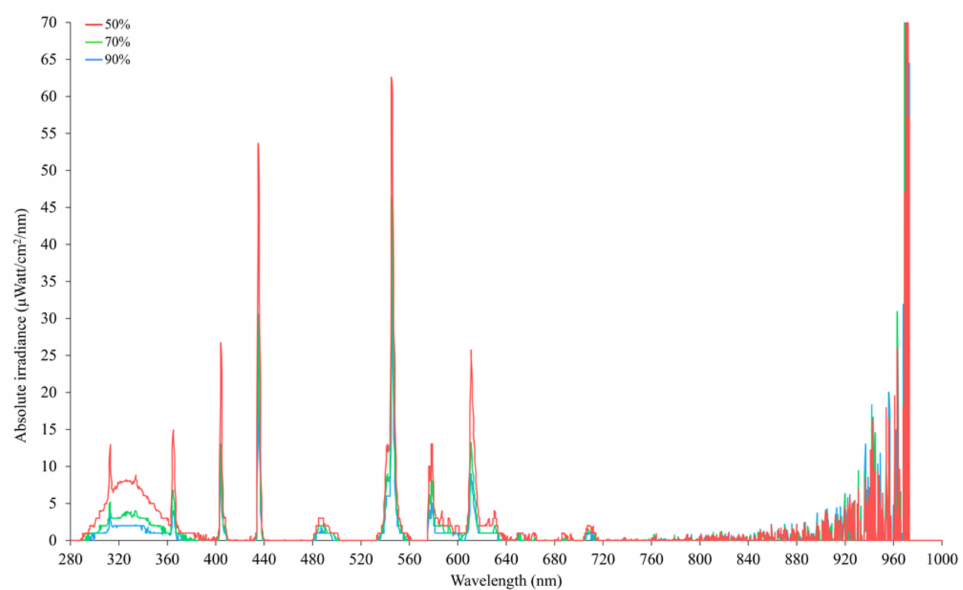
Figure 2. Spectral irradiance under different UV-filtering shade cloths (50%, 70%, and 90% UV block) as measured by an Ocean Insight Flame-S-XR1 Spectroradiometer at a distance of 20 cm with each type of shade cloth placed over a set of three Exo Terra ® (Rolf C. Hagen, Montreal, QC, Canada) pet reptile bulbs (Reptile UVB200, 25W,